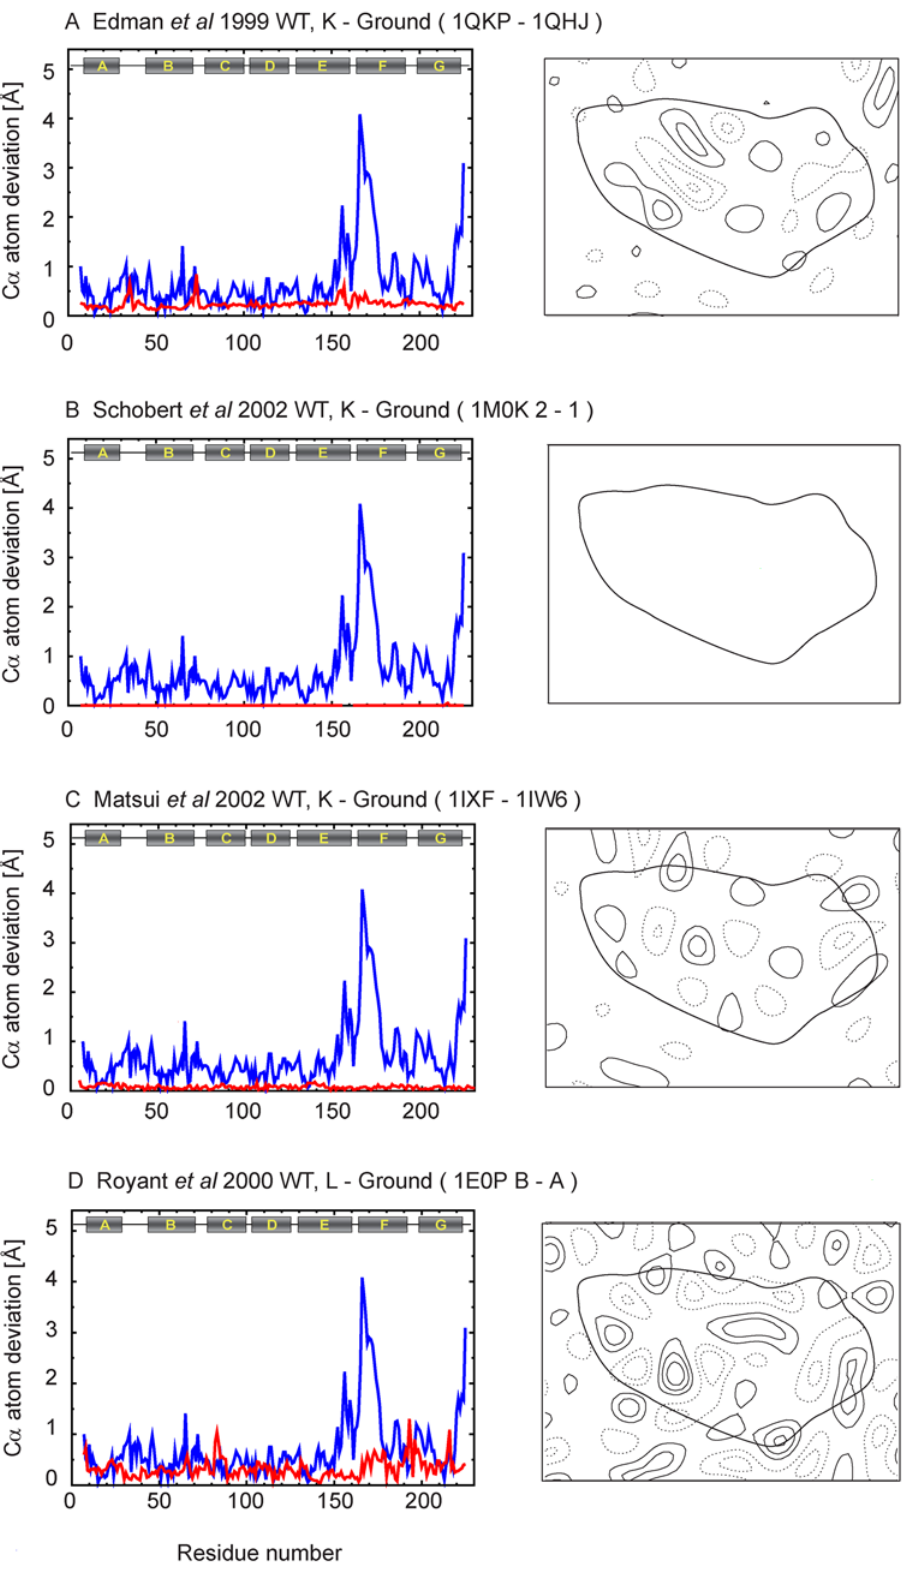
Figure 5. C a atom deviation plots and difference maps between intermediate and ground states calculated at 7 A˚. In the C a atom deviation plots, red line shows the C a atom deviation between intermediate and ground state after alignment using LSQMAN. For some plots, there are one or two gaps because there are missing residues either for intermediate or ground states. Blue line shows the deviation between 1FBK and 1FBB as a measure of reference. To calculate difference maps, we used common residues between intermediate and ground state; the retinal was always included. Lipids and water molecules were always excluded.